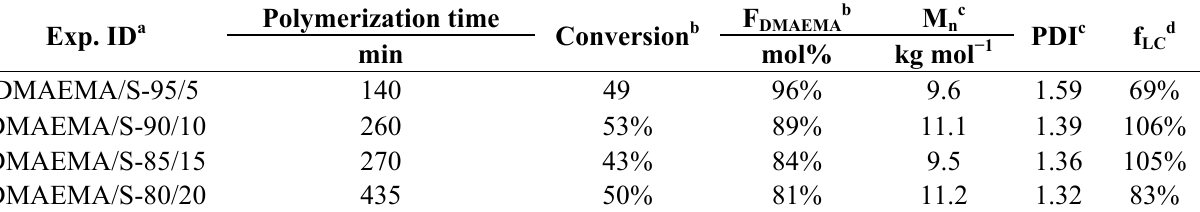
Table 3. Results of the copolymerizations of 2-(dimethylamino)ethyl methacrylate (DMAEMA) and styrene at 80 °C in bulk using N -hydroxysuccinimidyl-functionalized BlocBuilder as initiator.